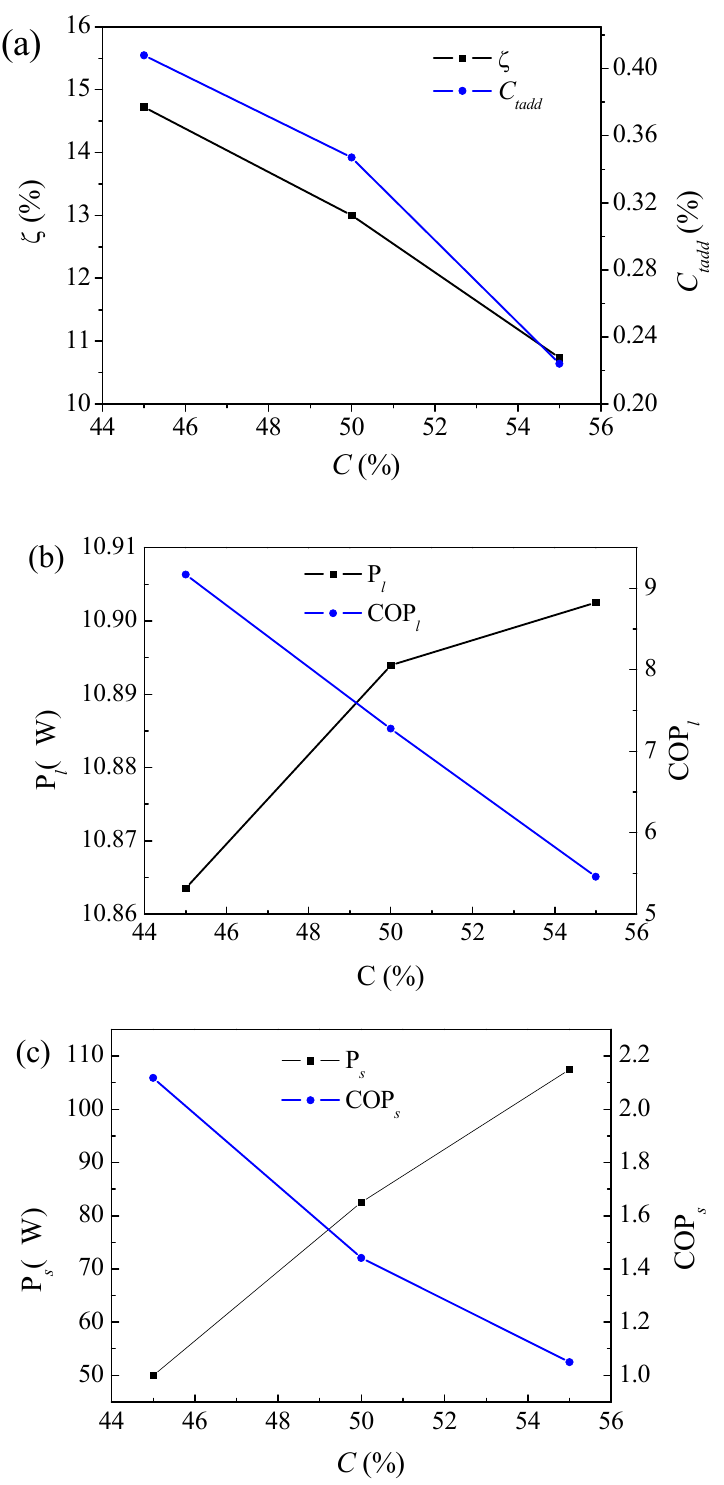
Figure 3. ( a ) Effect of initial concentration on regeneration performance of electrodialyzer; ( b ) effect of initial concentration on performance of electrodialysis regeneration system under theoretical conditions; ( c ) effect of initial concentration on performance of electrodialysis regeneration system under experimental conditions.